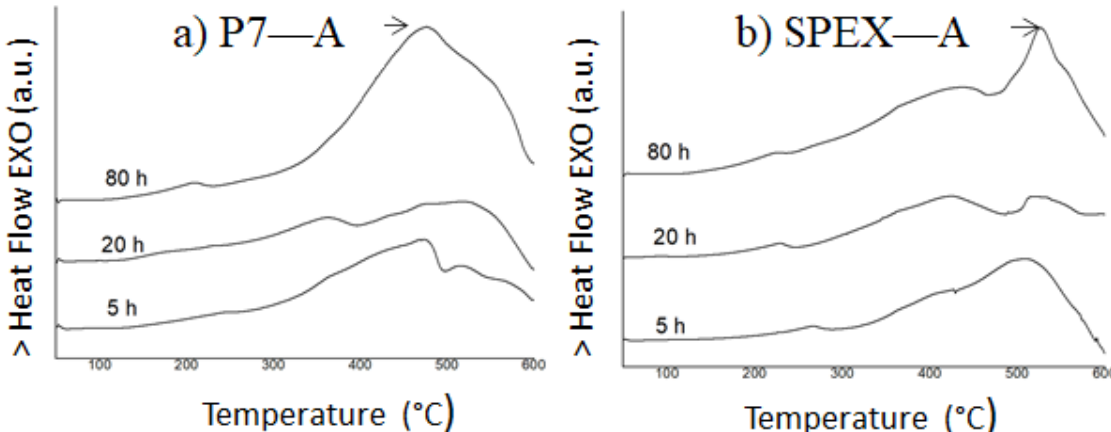
Figure 5. DSC (differential scanning calorimetry) scans of alloy A after milling (5, 20, 80 h) in the P7 ( a ) or in the Spex ( b ) mill.